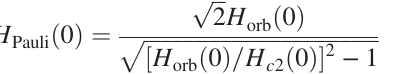
factor and the Bohr magneton, respectively. For all com- positions, μ 0 H strength — is well above μ 0 H